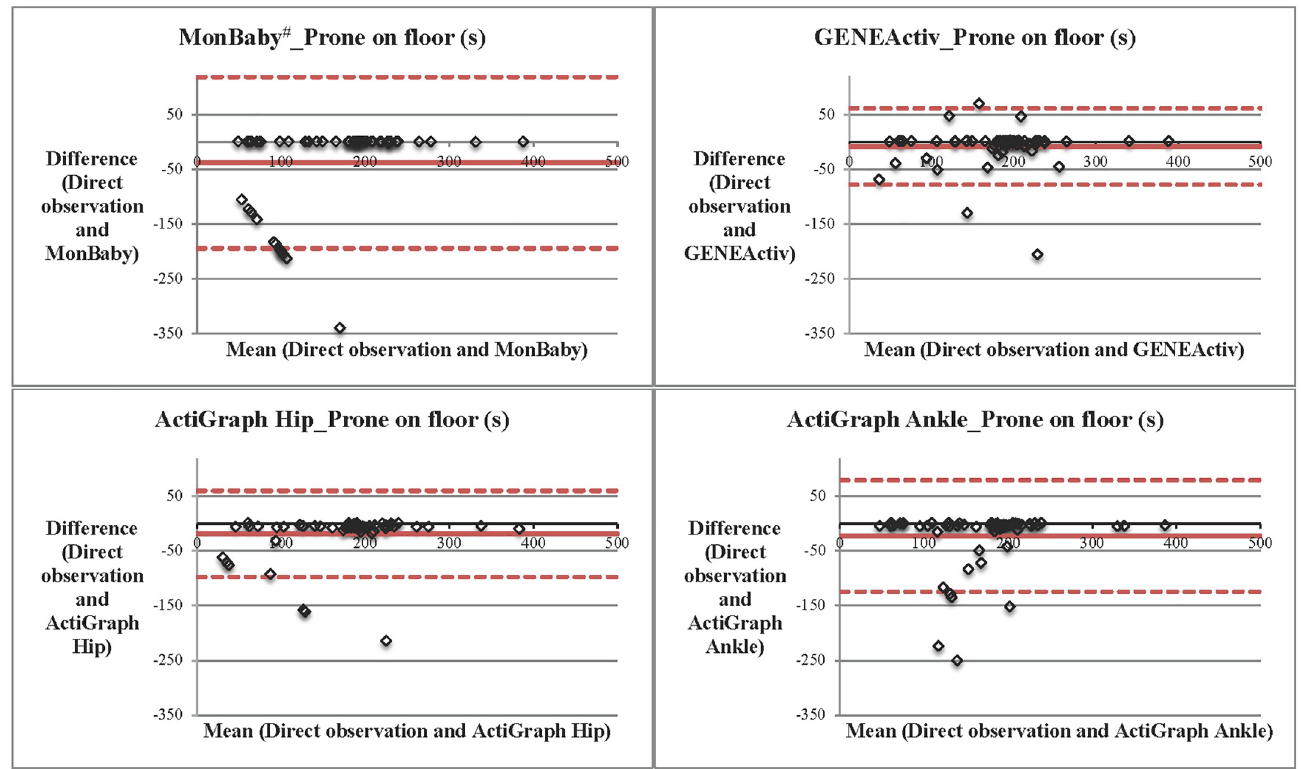
Fig 3. Bland-Altman plots of MonBaby, GENEActiv, ActiGraph Hip and ActiGraph Ankle for prone on floor positions. Graphs displays bias (full line), 95% limits of agreement (dashed lines) and individual participants (diamond shape); # MonBaby seconds estimated from percentage accuracy of the section downloaded for each individual participant.